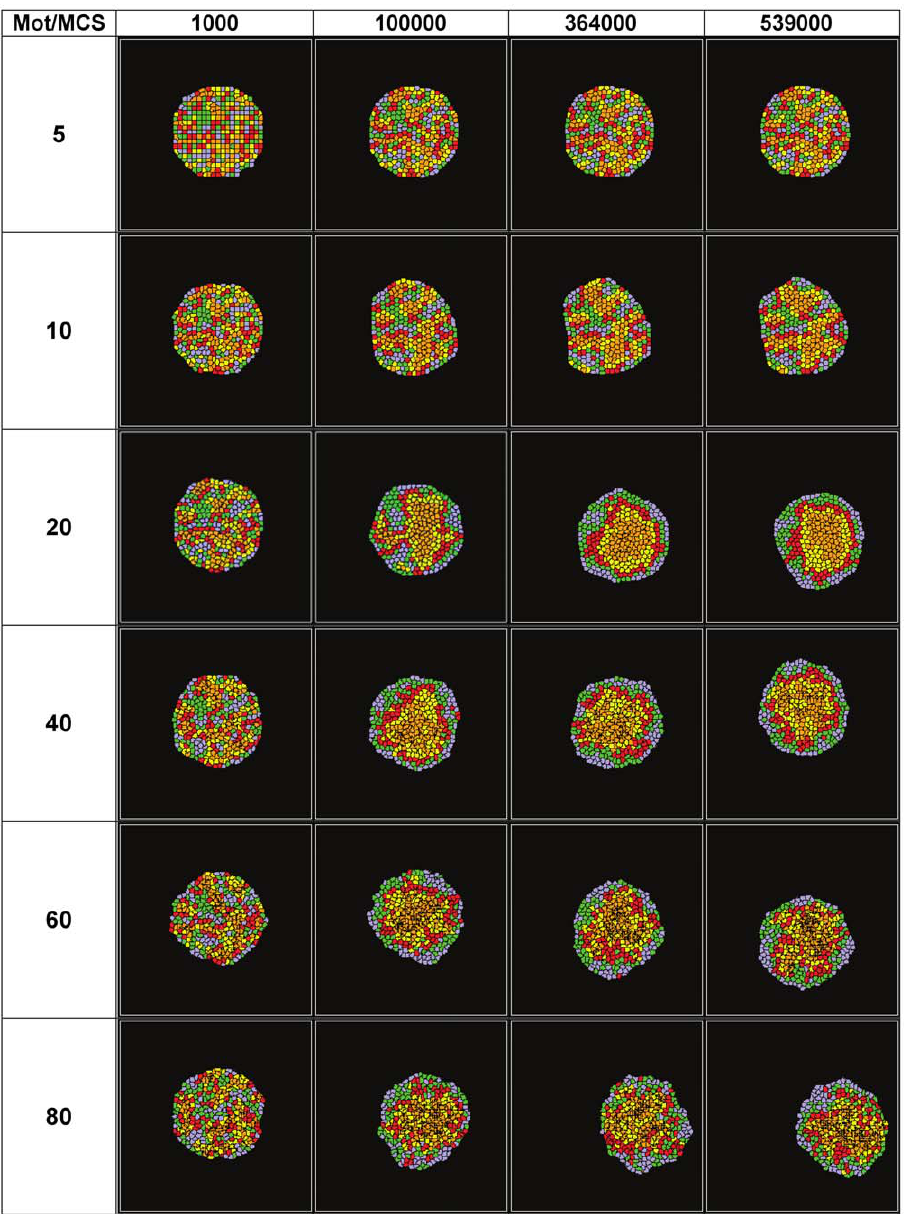
Figure 6. Simulation snapshots for aggregates with five levels [1, 6.5, 12, 17.5, 23] of cadherins and different cell motilities (5, 10, 20, 40, 60, 80), for the THBM. (See the animations in the supporting information.)